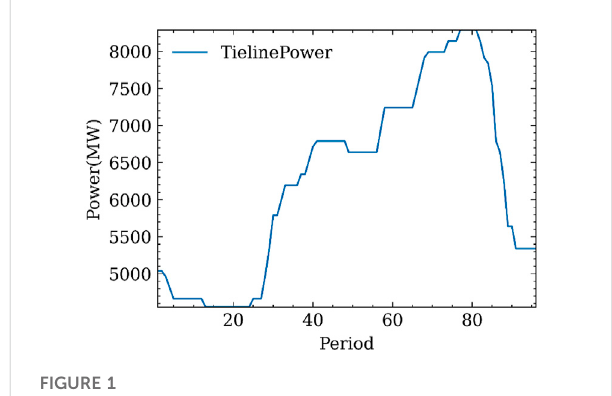
FIGURE 1 Total power curve of the whole system tie-line.